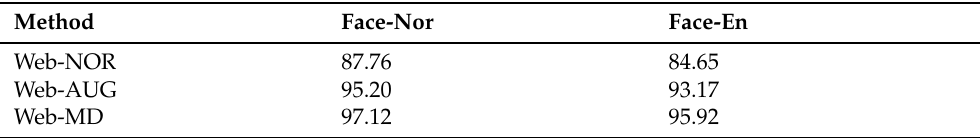
Table 2. Face verification comparison (%) on Face-Nor and Face-En when using different data set proportions.